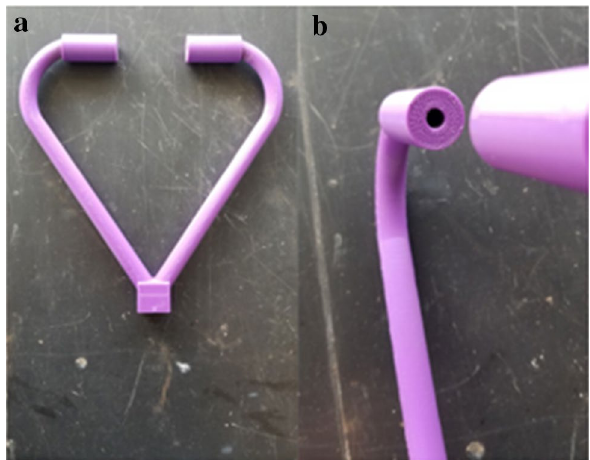
Figure 7. ( a ) The apparatus used to split the shockwave ( b ) the 0.25 inch diameter opening.